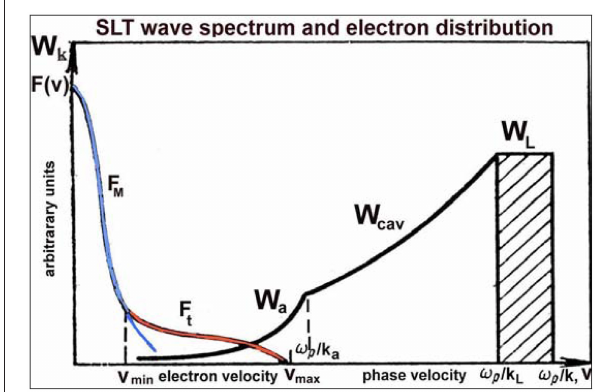
FIGURE 9 | Cartoon depicting the wave spectrum and electron distribution in the developed strong Langmuir turbulence. The wave energy in the long-scale ω pe / k L ), transfer ( W cav at ω pe / k a < ω l / k ω pe / k L ), source ( W L at ω l / k ≥ ≤ ω pe / k a ) intervals are indicated by the striped and absorption ( W a at ω l / k ≤ rectangle and solid black curves, respectively. The blue and red solid lines indicate the bulk and accelerated tail populations, respectively. After Shapiro and Shevchenko (1984). Reprinted by permission from Plenum